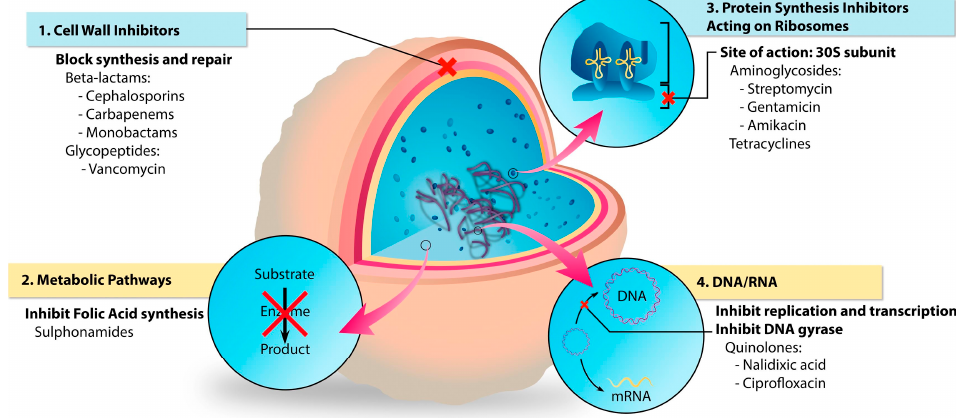
Figure 3. Representation of the different targets of antibiotics within bacteria. Reprinted with permission from [68]. Copyright 2022, Elsevier.